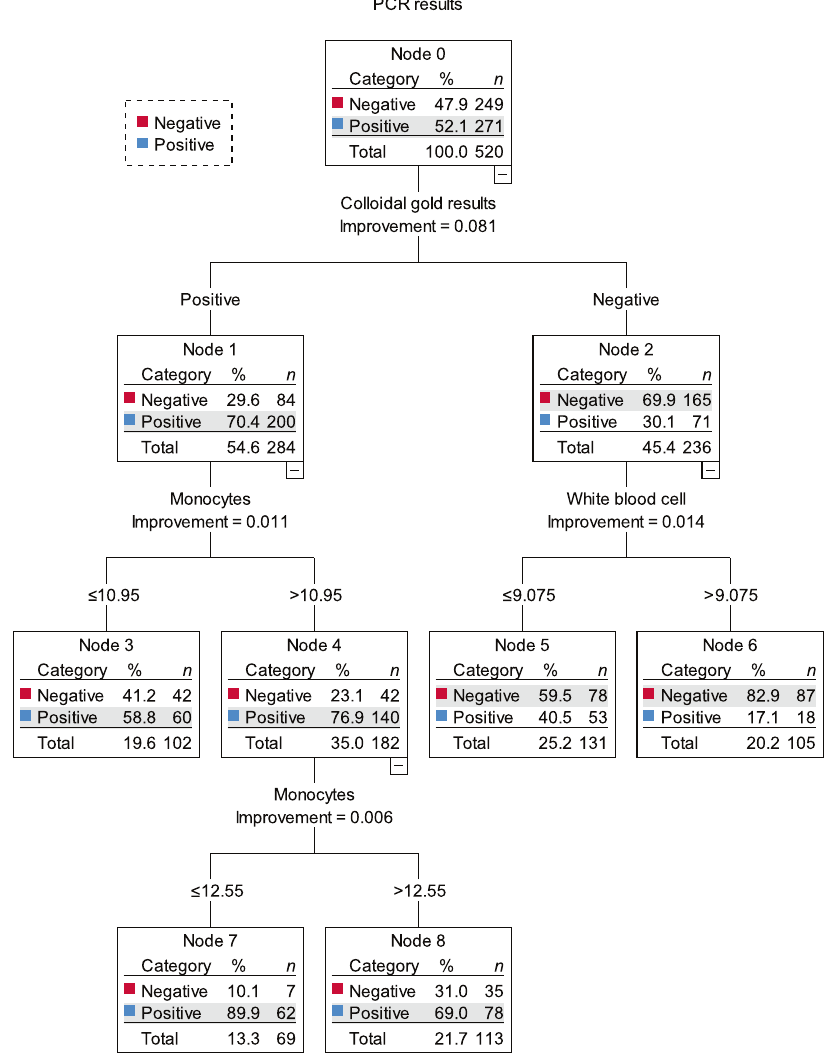
Fig. 1 Results of the in fl uenza diagnostic decision tree analysis. The CRT algorithm was used to construct a decision tree that had three layers, nine nodes, and fi ve terminal